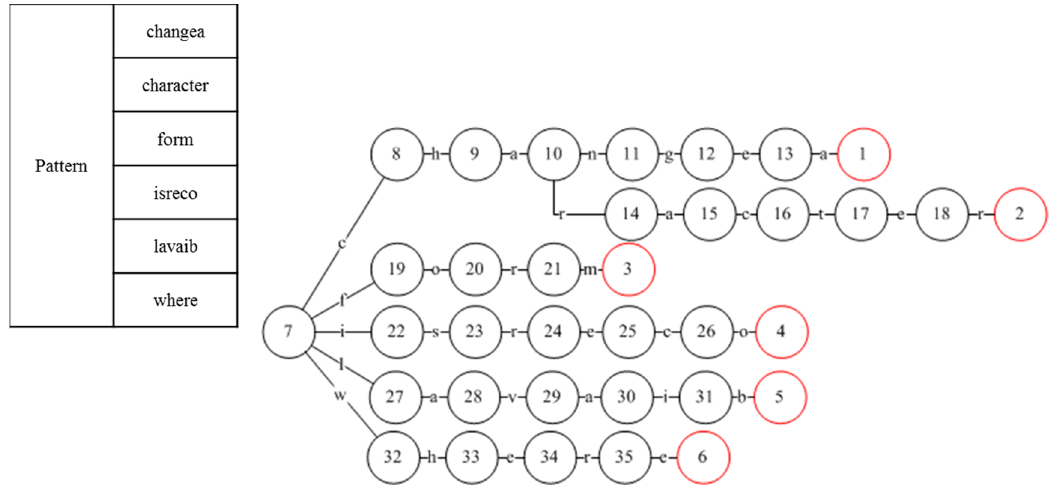
Figure 4. System-created PFAC machine based on six given patterns.